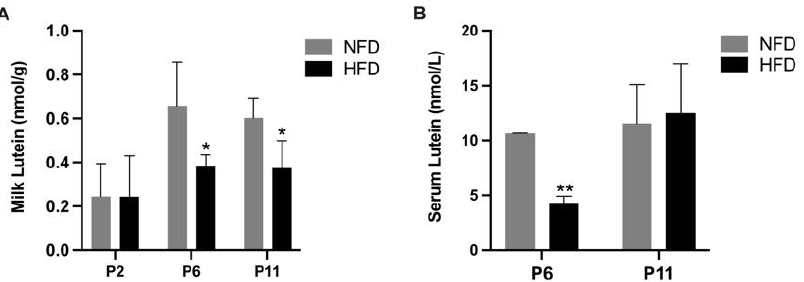
Figure 4. Concentrations of lutein in milk separated from the stomach of neonatal rats ( A ) and in the serum of neonatal rats ( B ). Bars show mean ± SD, n = 7 per group. Significant differences between groups were indicated by *, p < 0.05 and **, p < 0.01. At P2, serum samples were not adequate for analysis, and therefore, data are missing.